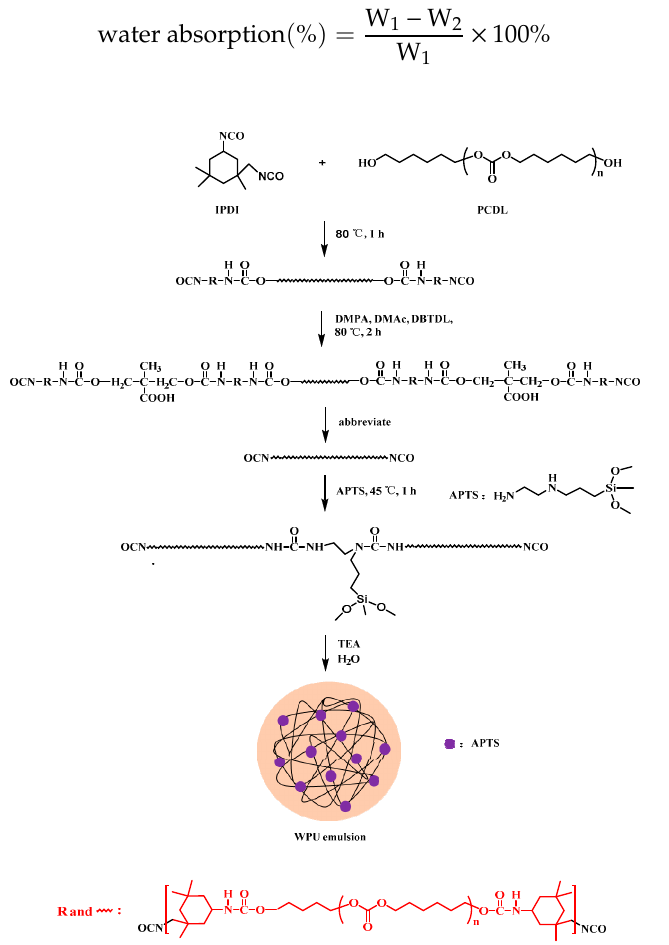
Figure 1. The synthesis process of waterborne polyurethanes (WPU) modified with APTS.